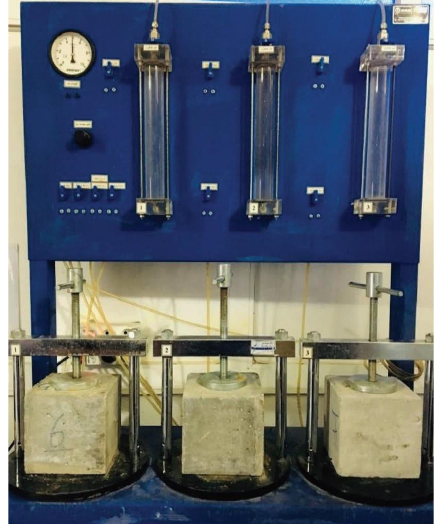
Figure 4: Depth of penetration test of water under